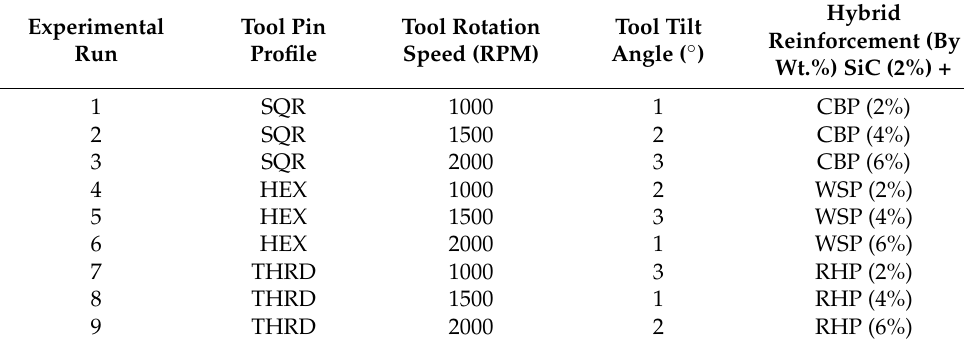
Table 4. L 9 orthogonal array.